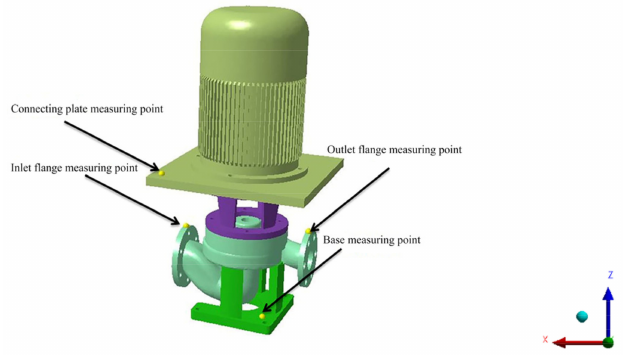
Figure 15. The position of each vibration measuring point of the pump